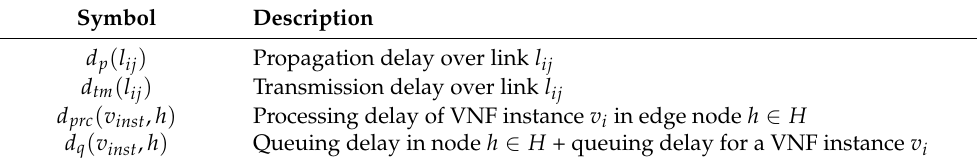
Table 3. Types of